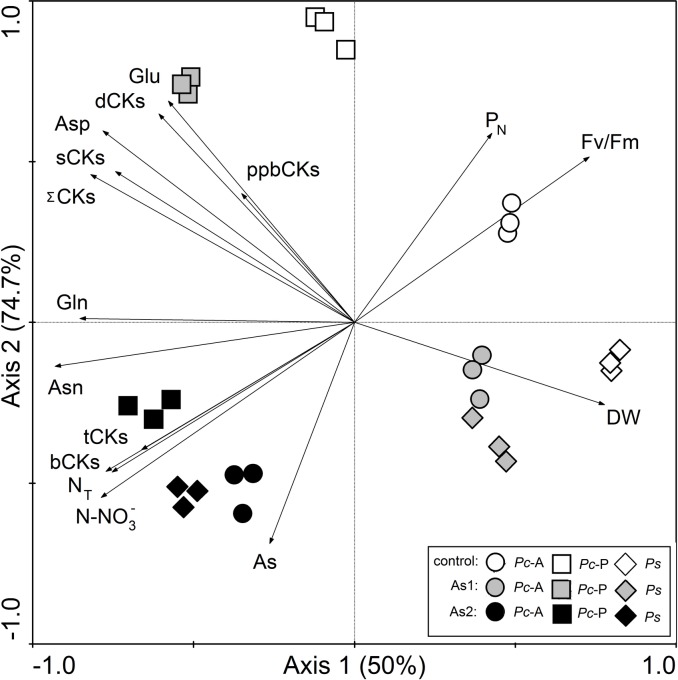
Ordination bi-plot of selected parameters in fronds of the As-hyperaccumulator ferns P. cretica var. Albo-lineata (Pc-A) and P. cretica var. Parkerii (Pc-P) and the As-non-hyperaccumulator fern P. straminea (Ps).The first axis of the PCA explains 50%, the first two axes 74.7% and the first four axes together 95% of the variability of all analyzed data. The length and the direction of the vectors indicate the strength of the vector effect and the correlation between the vectors, respectively. A long vector for a particular variable indicates that it is greatly affected the results of the analysis, while the opposite was true for a short vector. An angle of <90° between the vectors indicates that they are positively correlated. The angle of >90° between two vectors indicates that they are not positively correlated. The effect of the individual treatment differs between ferns. In Pc-P, in contrast to Pc-A and Ps ferns, the data for As1 treatment are clearly separated from all others. This indicates a large effect of As1 treatment on all of the recorded data in Pc-P and a minimal effect for Pc-A and Ps. The data for control and As2 treatments are located in different parts of the diagram, indicating a substantial effect of As2 application. Treatment abbreviations: control– 0 mg As·kg-1 soil; As1–20 mg As·kg-1 soil; As2–100 mg As·kg-1 soil. The background soil As content is 16 mg As·kg-1 soil. The difference between control and individual As treatments is the spiked As dose plus the 20% As extraction efficiency. Parameter abbreviations: DW–yield of dry frond biomass; As–arsenic; PN−net photosynthetic rate; Asp–aspartic acid; Asn–asparagine; Glu–glutamic acid; Gln–glutamine; NT−total nitrogen; N-NO3- –nitrate nitrogen; Fv/Fm–chlorophyll fluorescence; ΣCKs–total cytokinins; bCKs–bioactive cytokinin forms; dCKs–inactive (or weakly active) cytokinin forms; tCKs–transport cytokinin forms; sCKs–storage cytokinin forms; ppbCKs–primary products of cytokinin biosynthesis.